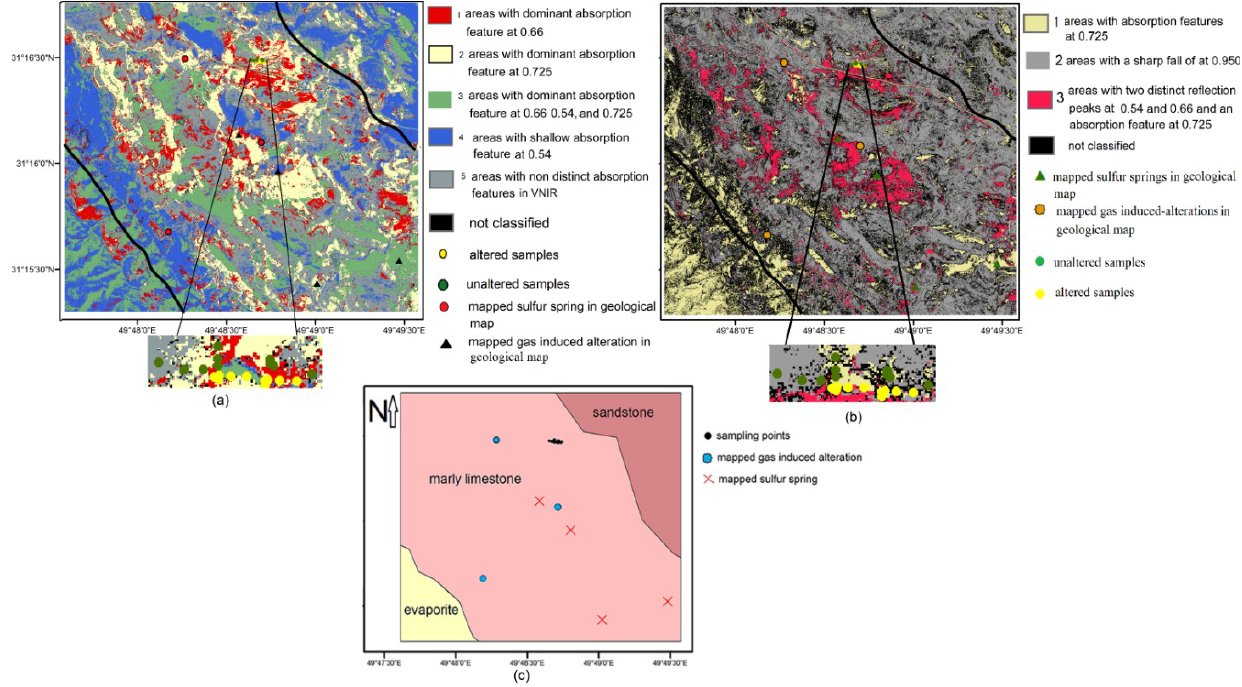
Figure 10. ( a ) Results obtained by the BRT classification with end-members extracted from the purest image pixels of WV-2; and ( b ) BRT classification using ROIs co-located with ground